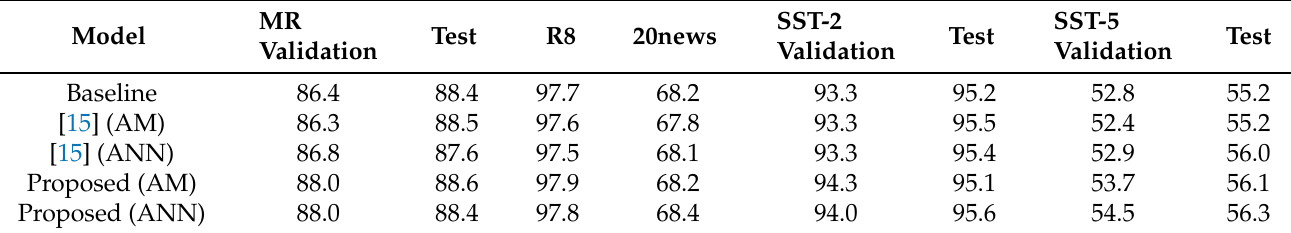
Table 5. Model performance on text classification with RoBERTa.